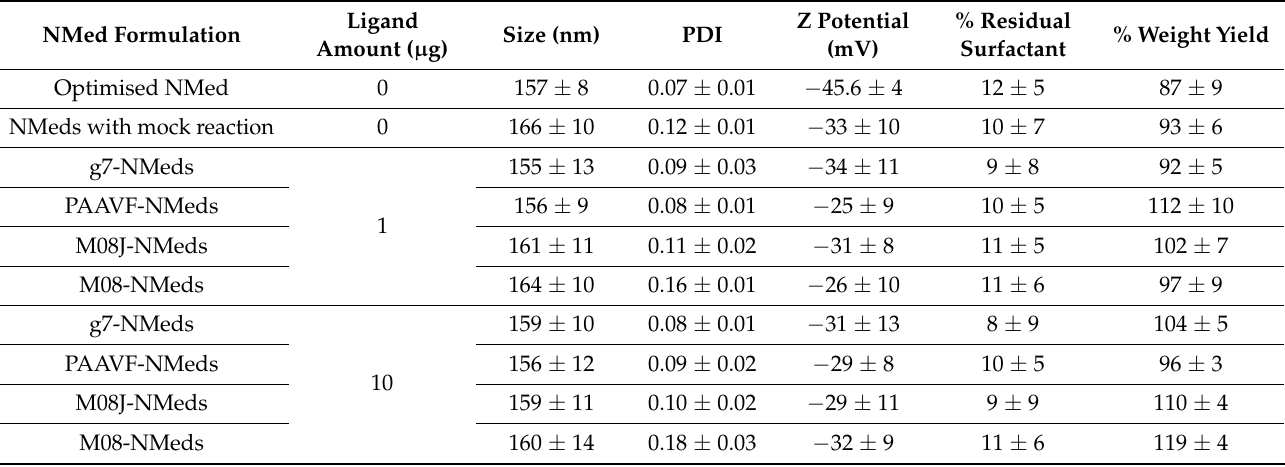
Table 1. Physico-chemical characteristics of ligand modified NMeds. Results are given as the median plus/minus the standard deviation